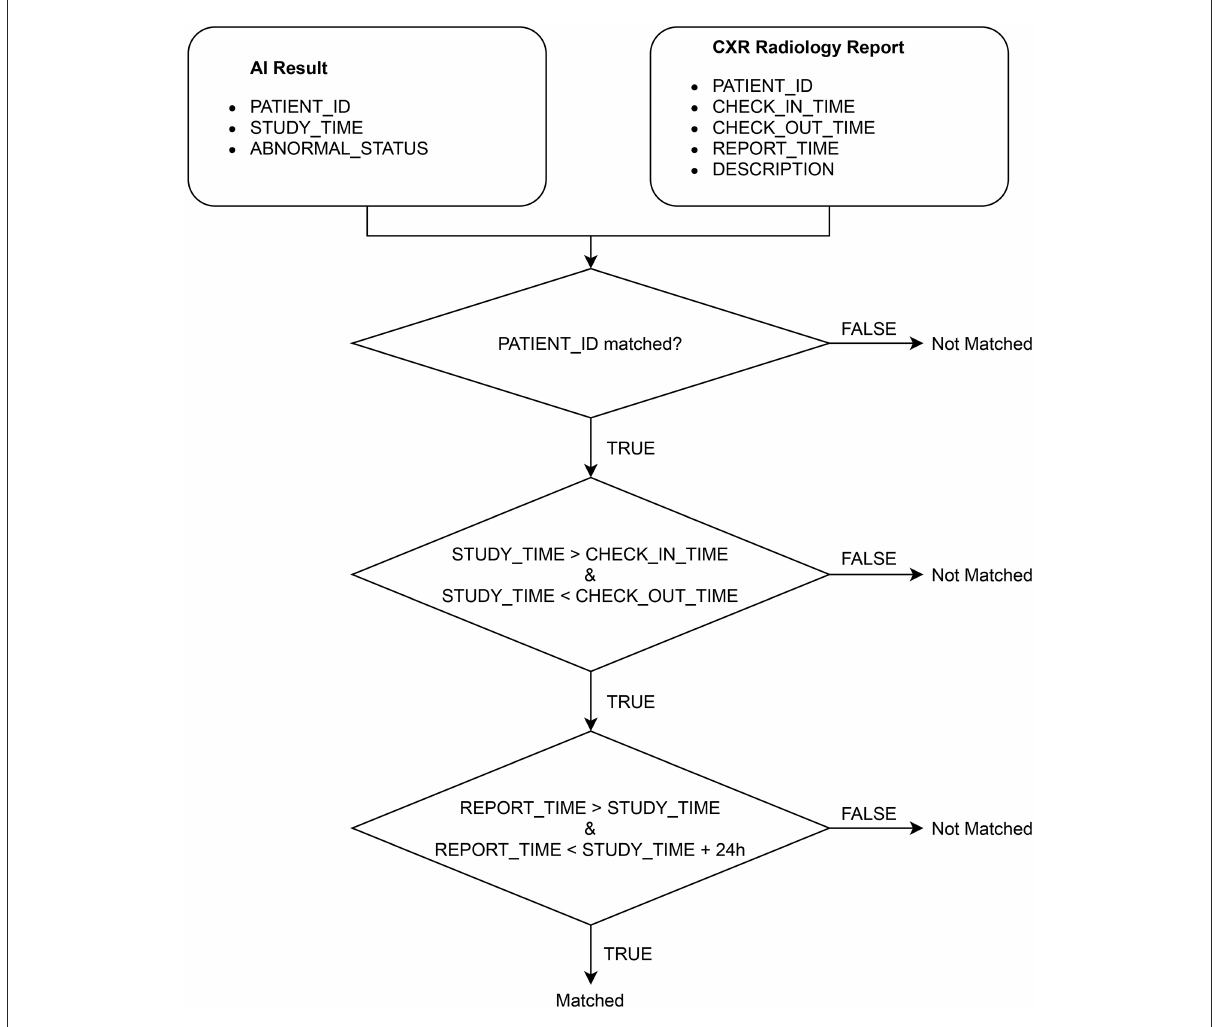
FIGURE4 Algorithm for matching an AI result with a radiology